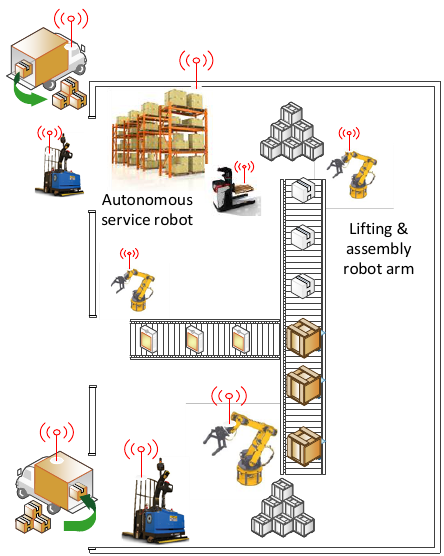
Figure 1. A diagram showing a factory automation application where raw materials and products need to be fetched from and delivered to different locations according to production